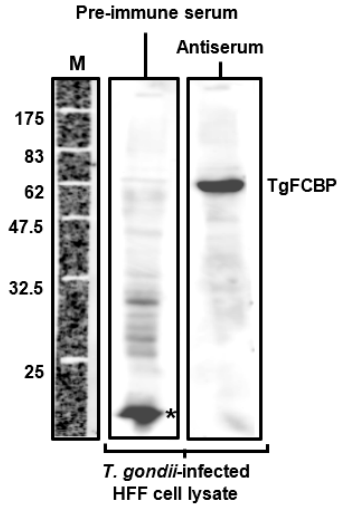
Figure A1. Specificity of the T. gondii FCBP (TgFCBP or TgFCBP57) peptide antibody. Immunoblot was performed as described above. Peptide serum, labeled as “antiserum”, detected the 57 kDa TgFCBP band, not detected by the pre-immune serum. Molecular weight markers (M) are indicated. The asterisked band reacted with pre-immune serum but not with the antiserum.